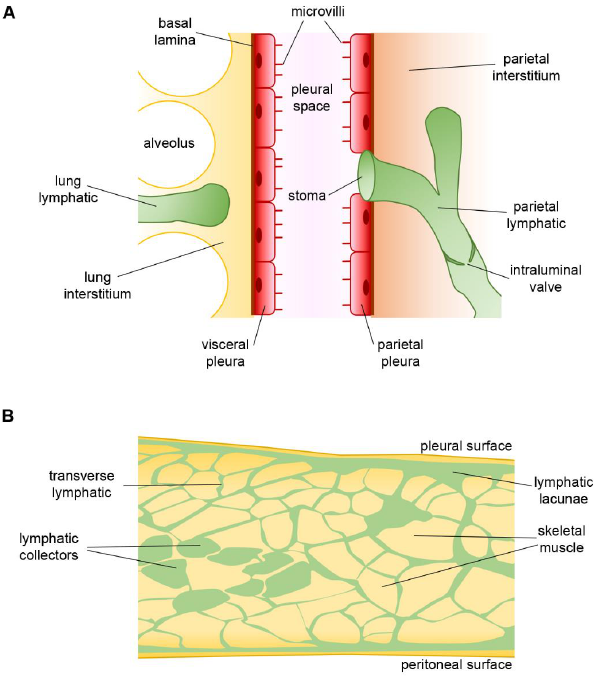
Figure 3. ( A ) Anatomical arrangement of parietal and visceral pleurae and the pleural space among them. Lymphatic stomata open directly into the pleural cavity. ( B ) Drawing of rat diaphragm cross section showing the reciprocal anatomical relationship among pleural and peritoneal submesothe- lial lymphatic lacunae, the transverse lymphatic network, and central lymphatic collectors (green). Skeletal muscle fiber bundles are shown in yellow and provide a strong extrinsic mechanical sup- port to lymph propulsion during spontaneous breathing. During spontaneous breathing the simultaneous recording of P L and P in (taken from the tissue surrounding the lymphatic vessel under investigation) showed a variability of both, related to the phase of the respiratory cycle [68]. Overall, P L and P in reach their lowest values at the end of the inspiratory phase (about − 28.5 and − 16.5 cmH 2 O respectively), with P L remaining subatmospheric and below P in most of the times (end-expiratory mean values are about − 3.4 cmH 2 O for P L and +4.2 cmH 2 O for P in ). This in turn results in a Δ P TM favoring lymph formation in most vessels during the whole respiratory cycle, with an apparent prevailing role of tissue displacement over RR to drive the mean value of Δ P TM and thus lymph draining. However, in a small fraction of the intercostal vessels Δ P TM fa- vors lymph propulsion for the entire respiratory cycle, whereas for some vessels their be- havior changes from formation to propulsion in the transition between inspiration and expiration. Therefore, the spontaneous respiratory activity maximizes lymph formation while preserving lymph progression along the lymphatic network, both being mecha- nisms essential for a proper control of the pleural liquid volume. The situation completely changes when the same pressure measurements are per- formed during controlled mechanical ventilation, even by setting respiratory parameters equal to spontaneous breathing. The major change happens in the P in and P L traces, since